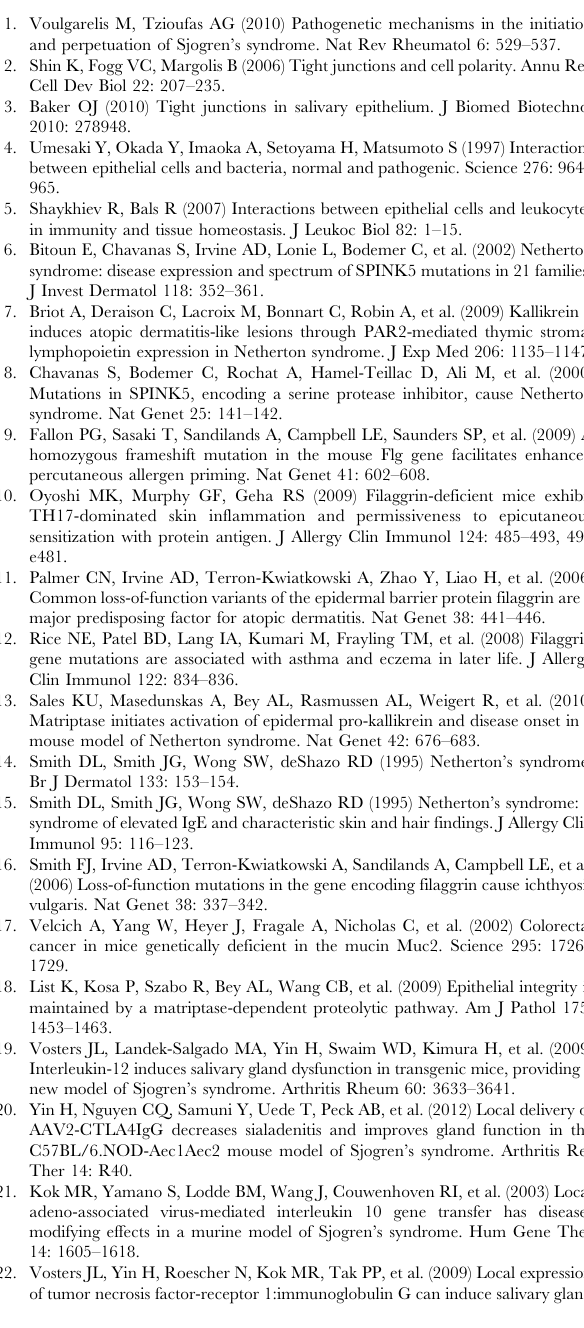
Figure S2 Detection of ZO-1 expression in matriptase deficiency and control mice. Immunofluorescent detection of ZO-1 in paraffin-embedded SMG tissue samples from 28 to 40 weeks St14 – and St14 + mice ( N= 2 both groups). Representative confocal images are shown. Apical staining of ductal cells for ZO-1 is shown by arrowheads. No significant difference was detected in St14 – mice compared with St14 + mice. Original magnification is